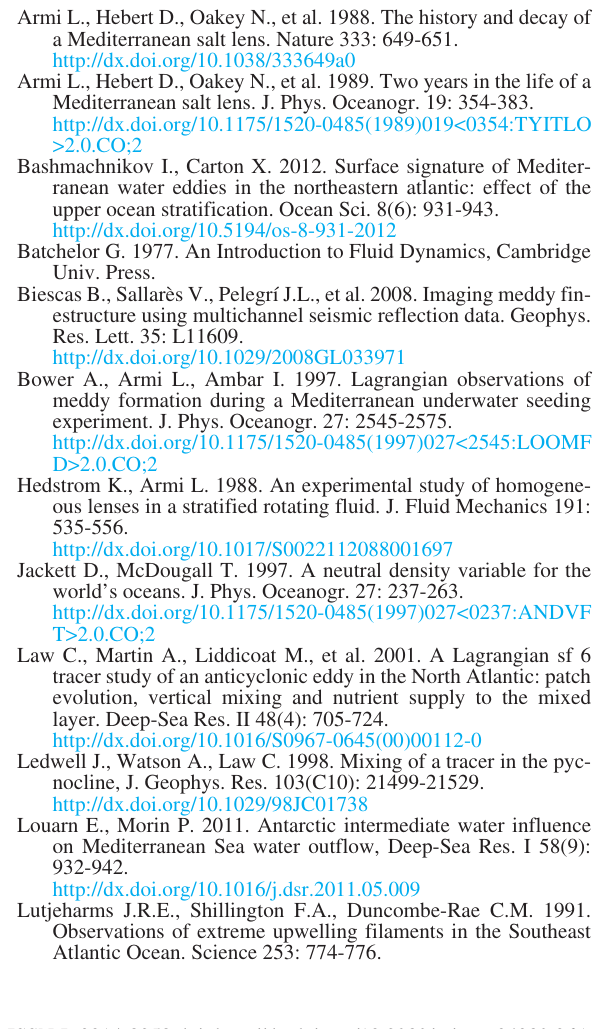
8. – Schematic diagram on how the salinity distribution be- comes modified by the presence of a meddy (contours represent isohalines, with the numbers indicating a relative level of salt con- tent). In the absence of a meddy, the isohalines are approximately horizontal with a well-defined minimum at the AAIW level (solid lines). The appearance of the meddy (dotted lines) brings a large positive salt anomaly immediately below the minimum AAIW sa- linity level but the overlaying layers are not immediately affected but progressively incorporate the low-salinity waters through diffu- sion, first showing up as a halo and eventually as a beret. When the meddy returns back north, to the region with no AAIW influence, the beret of low-salinity waters will progressively erode, from its edges towards the centre (the dashed lines illustrate the progression of states, from light to dark grey colours as time